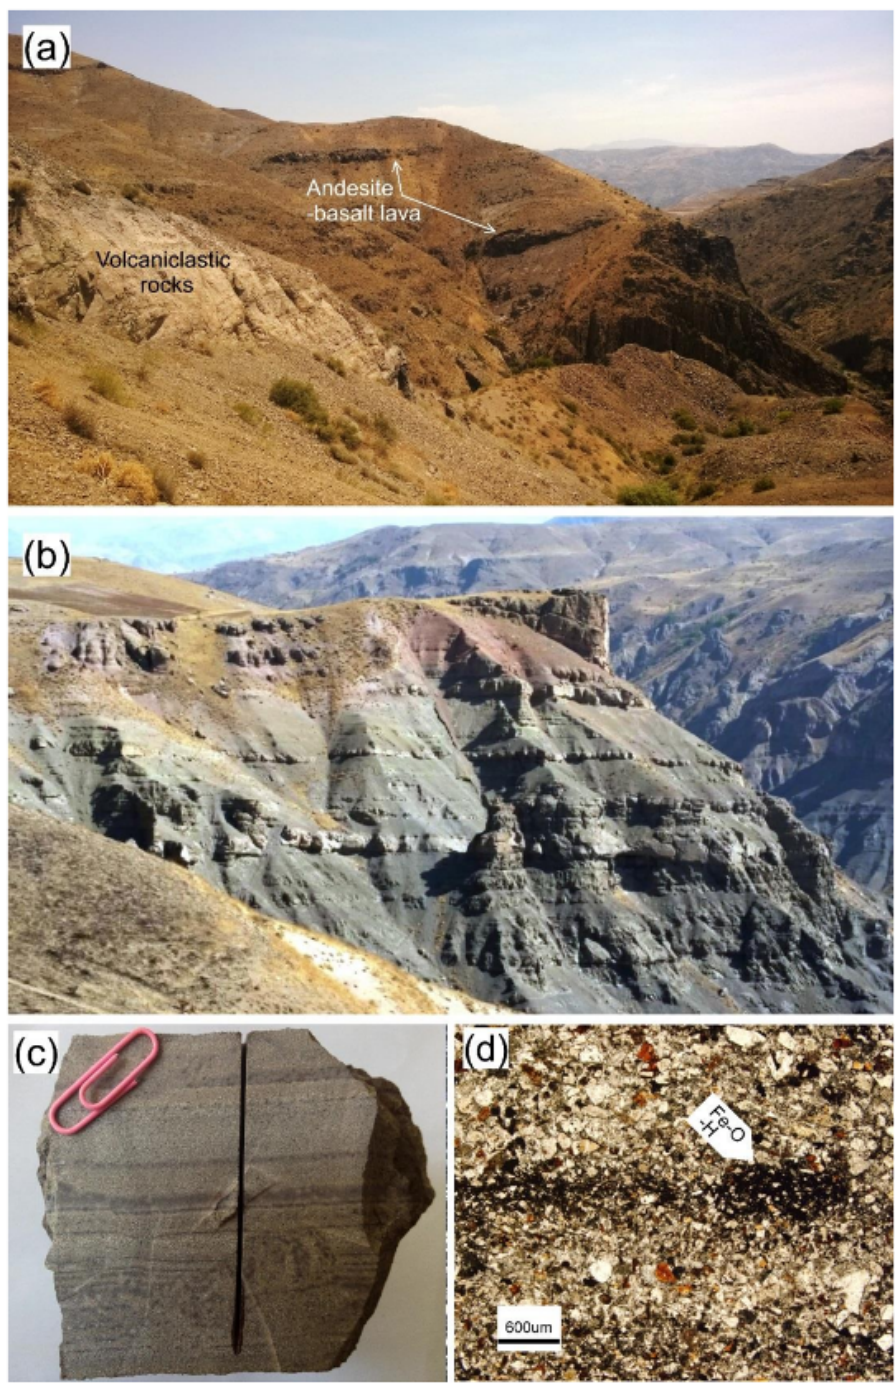
Figure 5. Field photographs and photomicrographs of Shah-Ali-Beiglou area: ( a ) Eocene lava flows occurring as interlayers in the volcaniclastic rock unit; ( b ) Outcrop of volcaniclastic rocks containing thin-bedded texture; ( c ) Hand sample of crystal tuff with banded texture; ( d ) Crystal tuffs with banded texture (PPL). Fe-O-H: